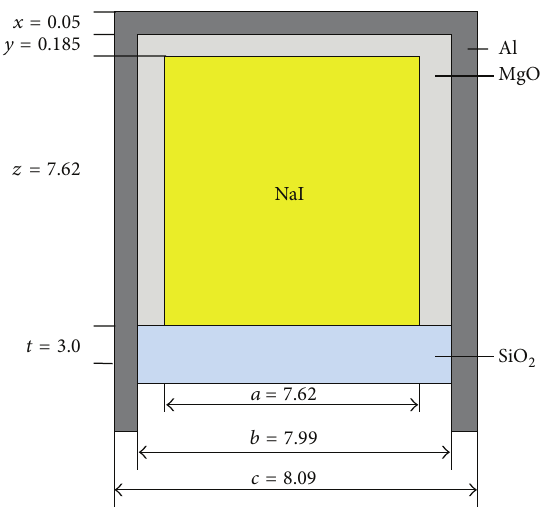
Figure 1: Schematic representation of NaI(Tl) detector considered in simulation.